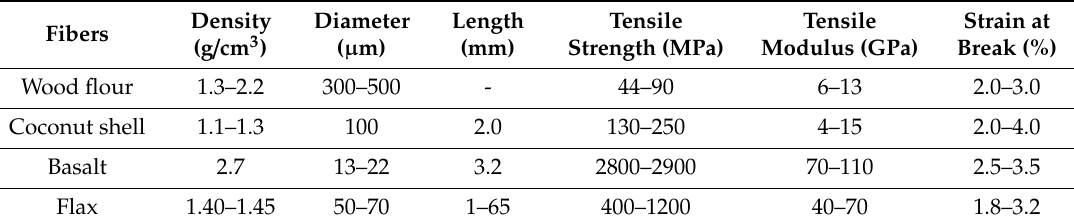
Table 3. Physic–mechanical properties of used fibers